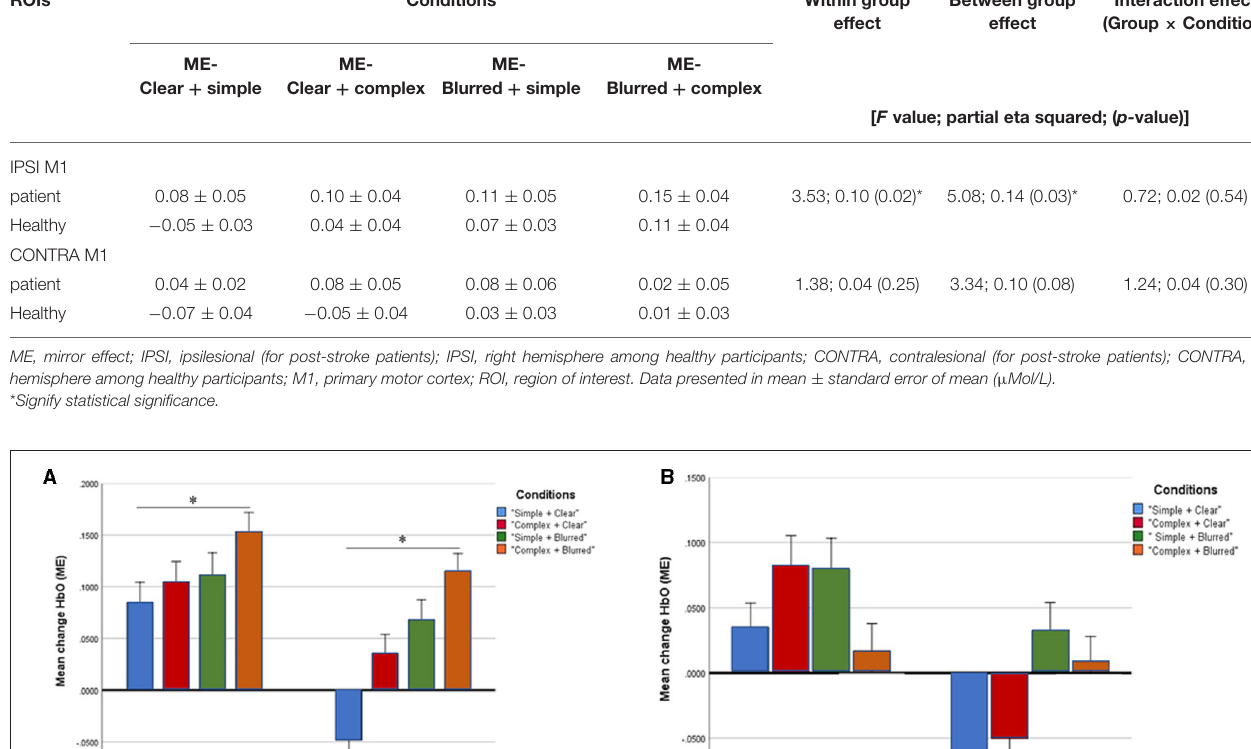
TABLE 3 | Changes in [HbO] (ME) in left and right M1 throughout 20s finger tapping among four conditions for patient ( n = 15) and healthy groups ( n = 18). ROIs